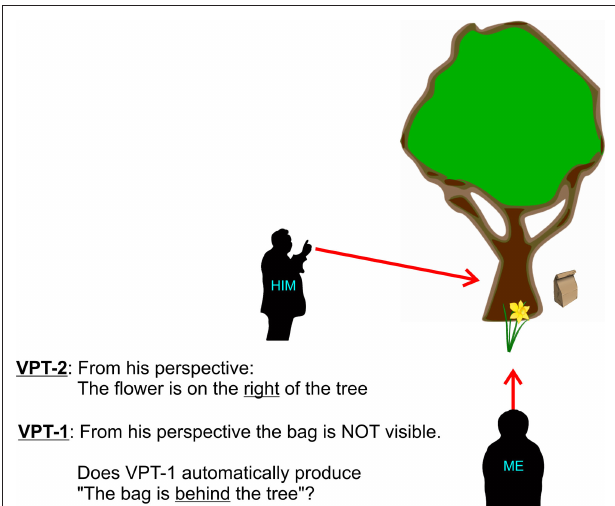
Figure 1 | Level 1 vs. level 2 perspective taking. According to Flavell et al. (1986) level 1 perspective taking (VPT-1) requires understanding of what lies within someone else’s line-of-sight. Level 2 (VPT-2) involves mentally adopting someone else’s spatial point of view. Determining that the flower is on the “right” of the tree from the other person’s perspective requires a more complex transformation than VPT-1. VPT-2 has been generally related to tasks that require relative judgments and which prominently include verbal localizations that use “left of” and “right of” (Michelon and Zacks, 2006). In contrast, VPT-1 has been related so far only to visibility judgments, but we propose that VPT-1 also extends to the language domain and subserves verbal localizations that use “in front of” and “behind of.” Further explanations in the text.